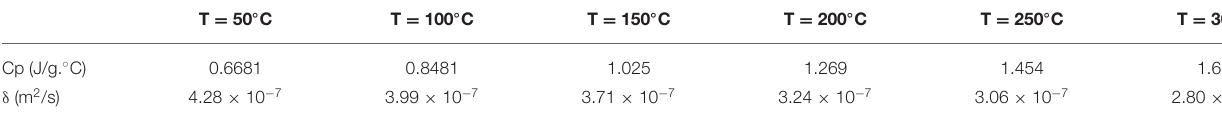
TABLE 1 | Thermal properties of the prepreg.